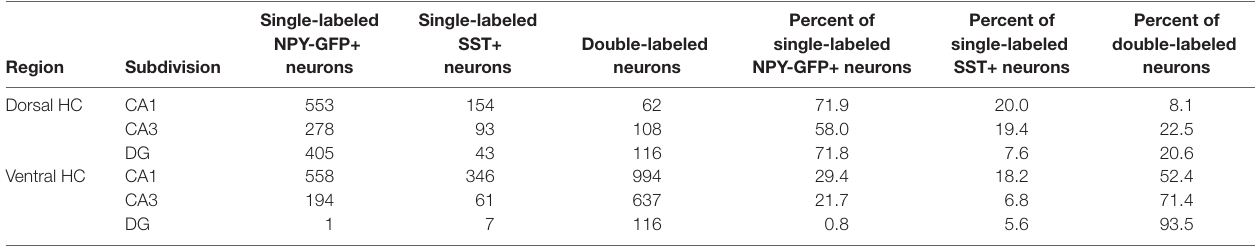
TABLE 3 | Co-localization of NPY-GFP and SST in the hippocampus. Single-labeled Single-labeled Percent of Percent of Percent of NPY-GFP+ SST+ Double-labeled single-labeled single-labeled double-labeled Region Subdivision neurons neurons neurons NPY-GFP+ neurons SST+ neurons neurons Dorsal